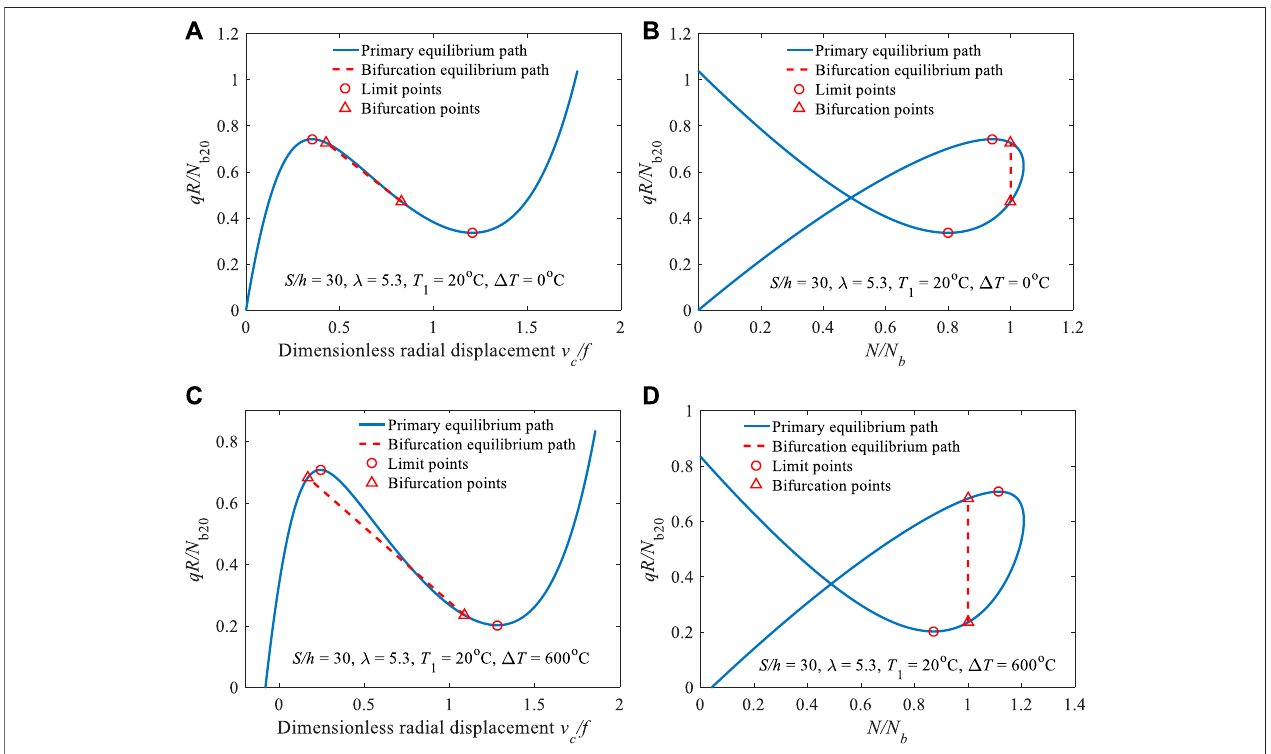
FIGURE 6 | Nonlinear equilibrium paths of the arch under (A) and (B) Δ T (cid:1) 0 o C, (C) and (D) Δ T (cid:1) 600 o C.